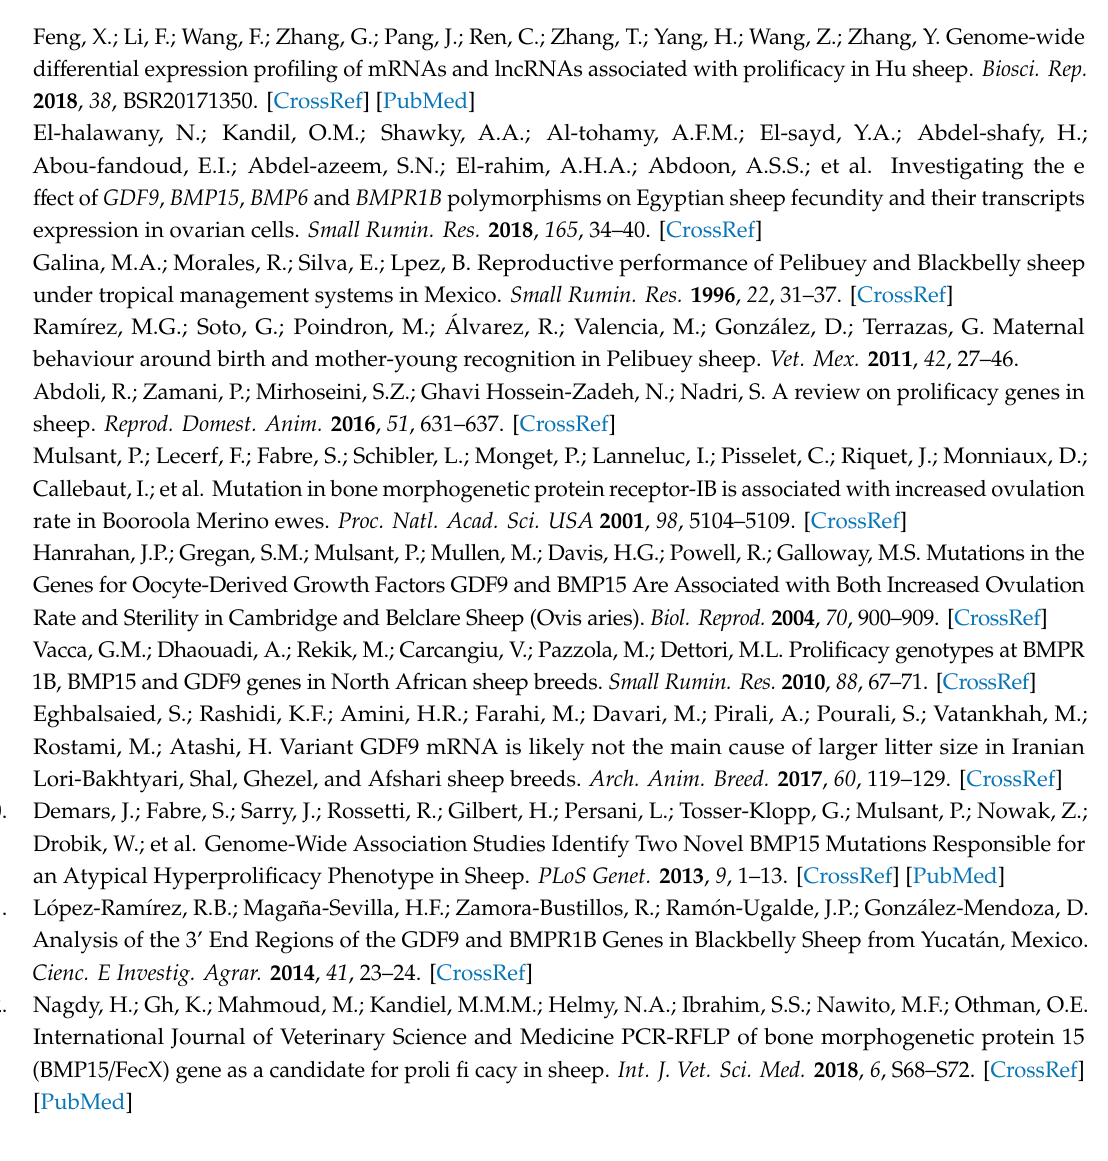
Table S1: Di ff erentially expressed genes involved in the ovary development process in Pelibuey sheep, Table S2: Metabolic pathways identified and related to reproductive processes in Pelibuey